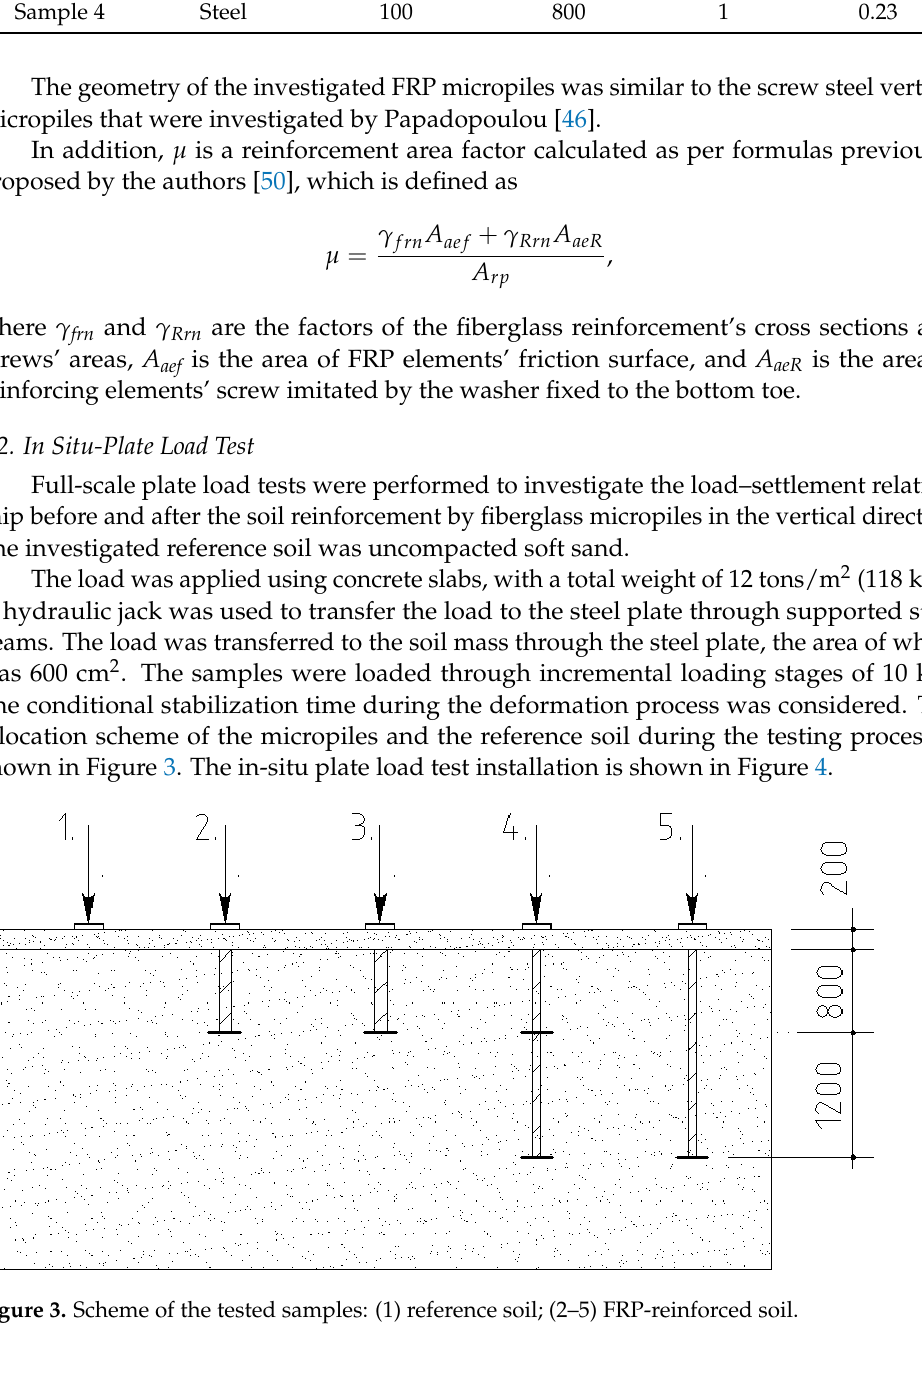
Figure 4. The in-situ plate load test system used in the experiment. The obtained results were compared relatively before and after the reinforcement process to determine the changes in the composite deformation properties. 2.3. Background on a Previously Proposed Theoretical Settlement Calculation Method Furthermore, the settlement of each in-situ tested sample was calculated according to a settlement calculation method previously proposed by one of the authors [50] to verify the reliability of the proposed calculation method (Figure 5). This previously proposed method assumes the following: •